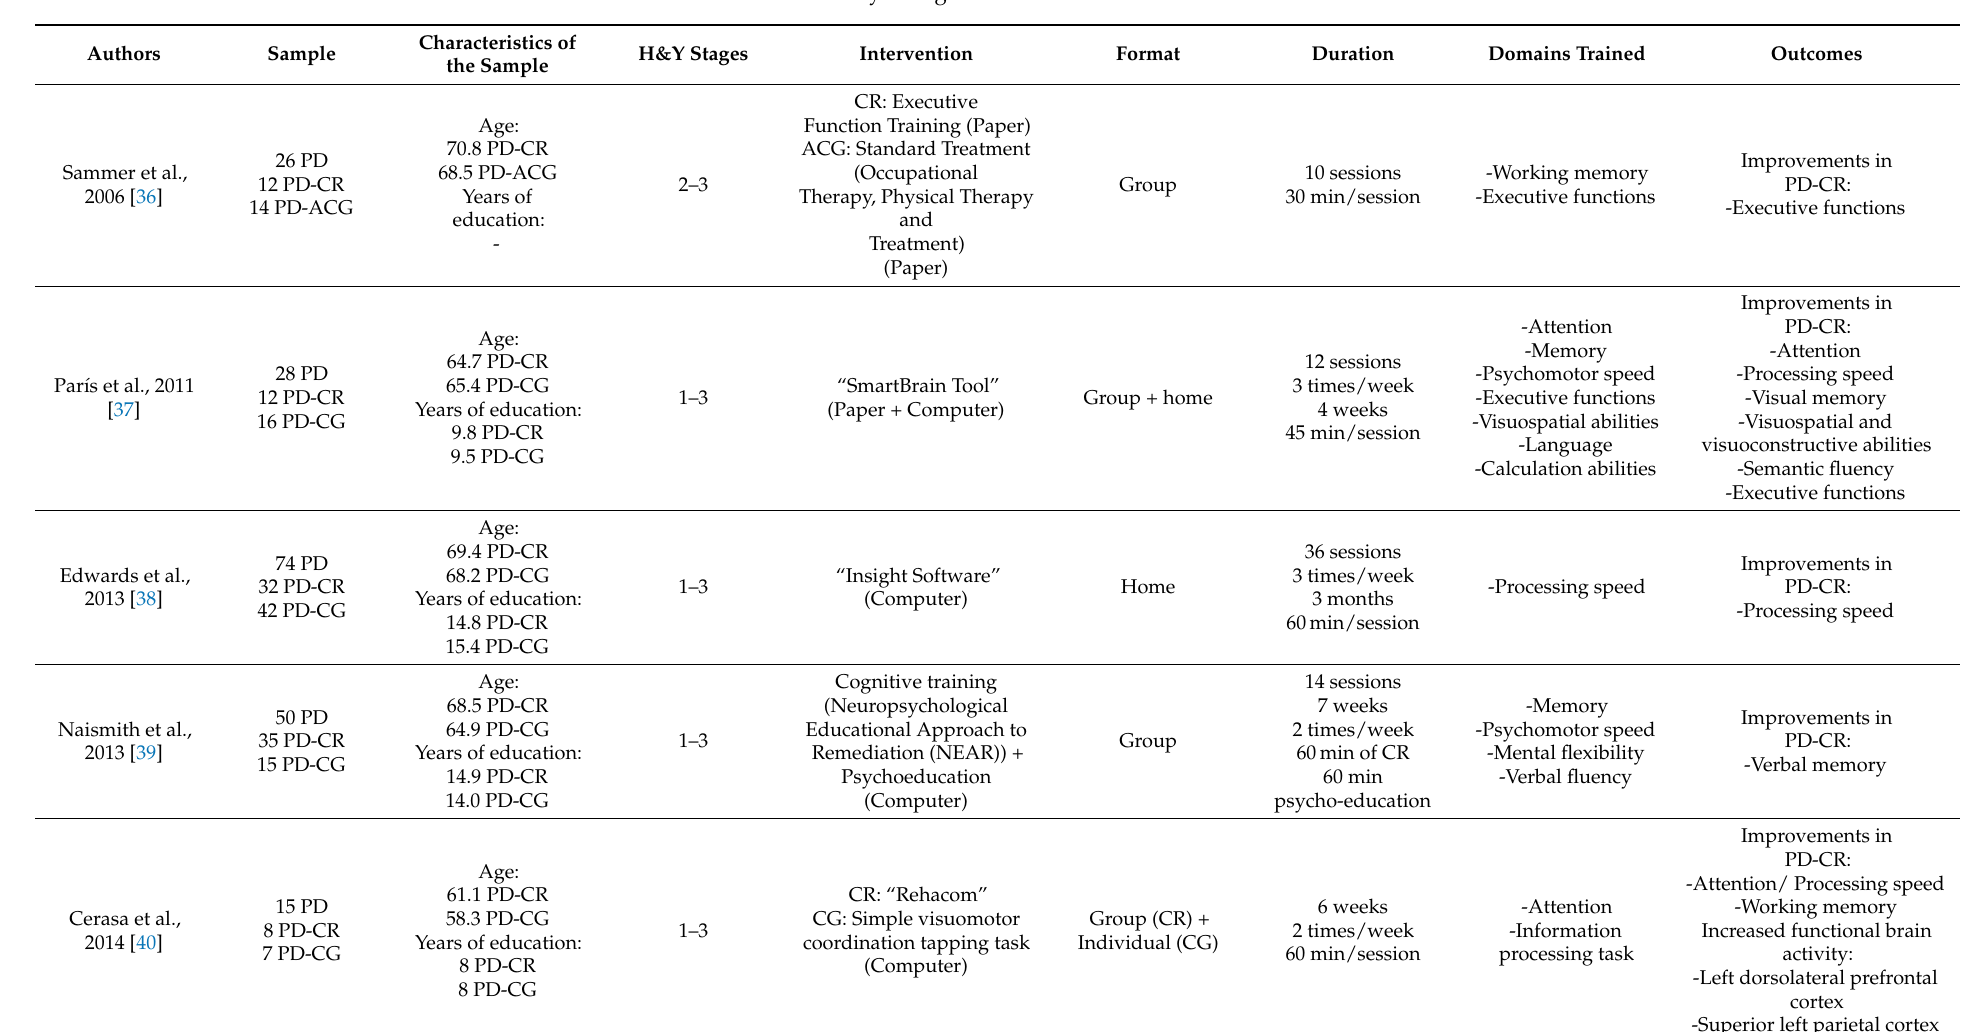
Table 1. Summary of cognitive rehabilitation studies for